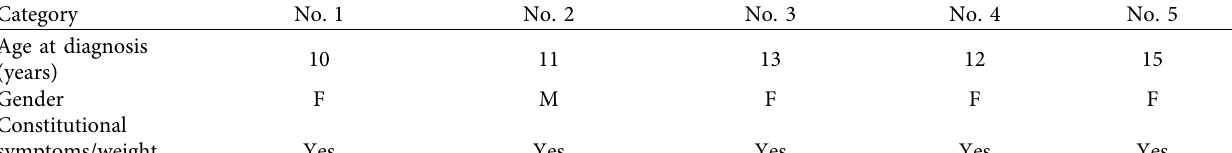
Generalized tense